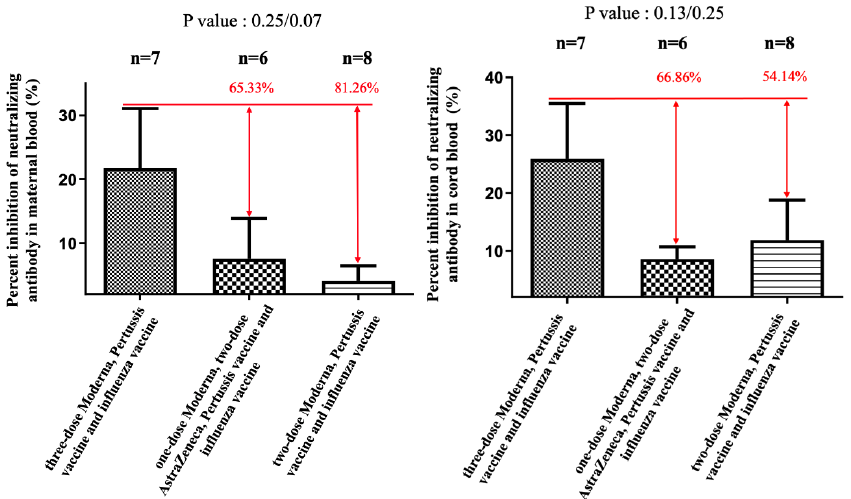
Figure 1. The percentage of neutralizing antibody inhibition against the Omicron variant in maternal and cord blood. In the two-dose AZ plus two-dose Moderna group, there was a 65.33% reduction ( p = 0.25) in maternal blood and a 66.86% ( p = 0.13) reduction in cord blood compared with the three-dose Moderna group. In the two-dose Moderna group, there was an 81.26% reduction ( p = 0.07) in maternal blood and a 54.14% ( p = 0.25) reduction in cord blood compared with the three-dose Moderna group.